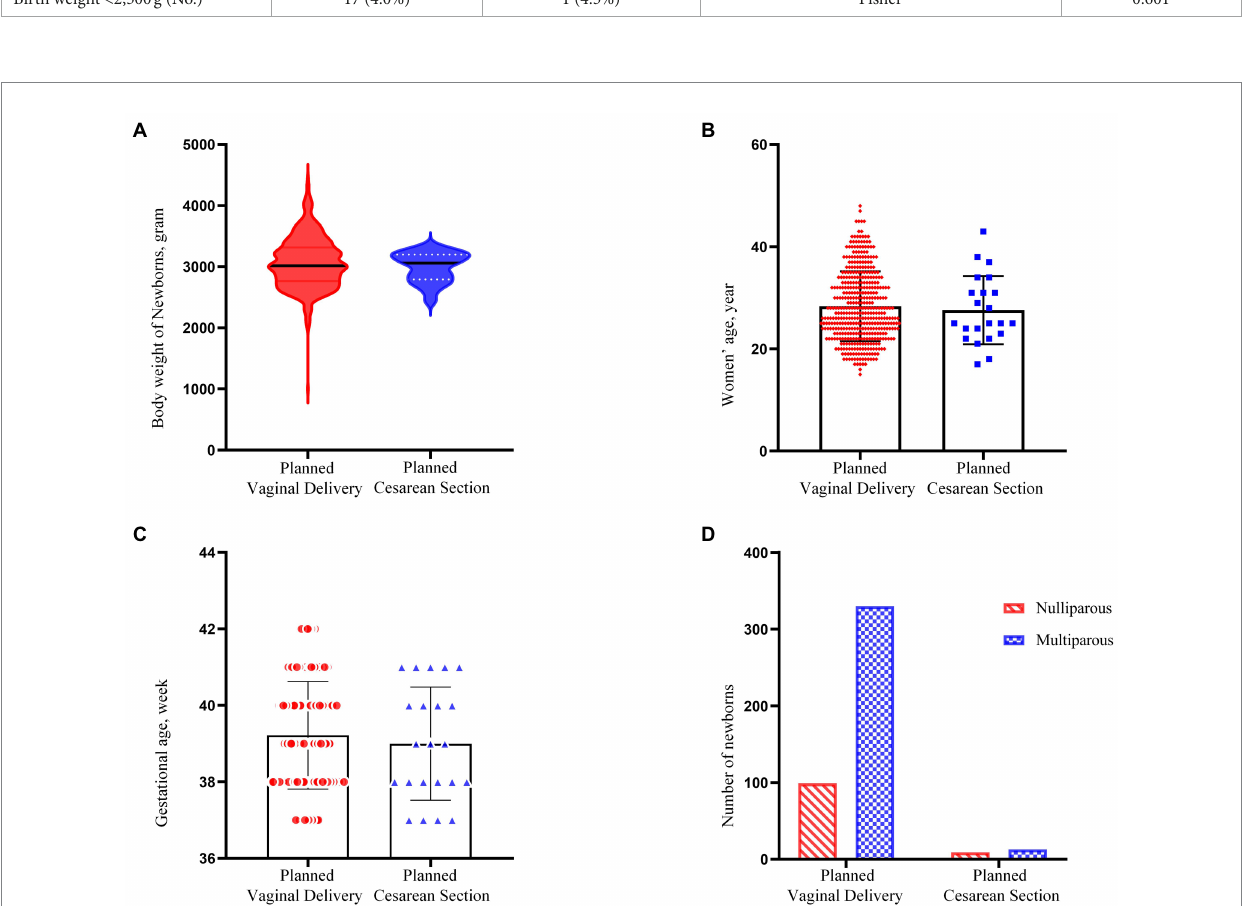
FIGURE 2 Comparison between two modes of breech delivery. (A–C) Shows a comparison of body weight of newborns, maternal age and gestational age between the planned vaginal delivery group and the planned cesarean delivery group ( p = 0.215, 0.610, 0.478, respectively). (D) Shows the number of multiparous and nulliparous between two modes of delivery ( p =